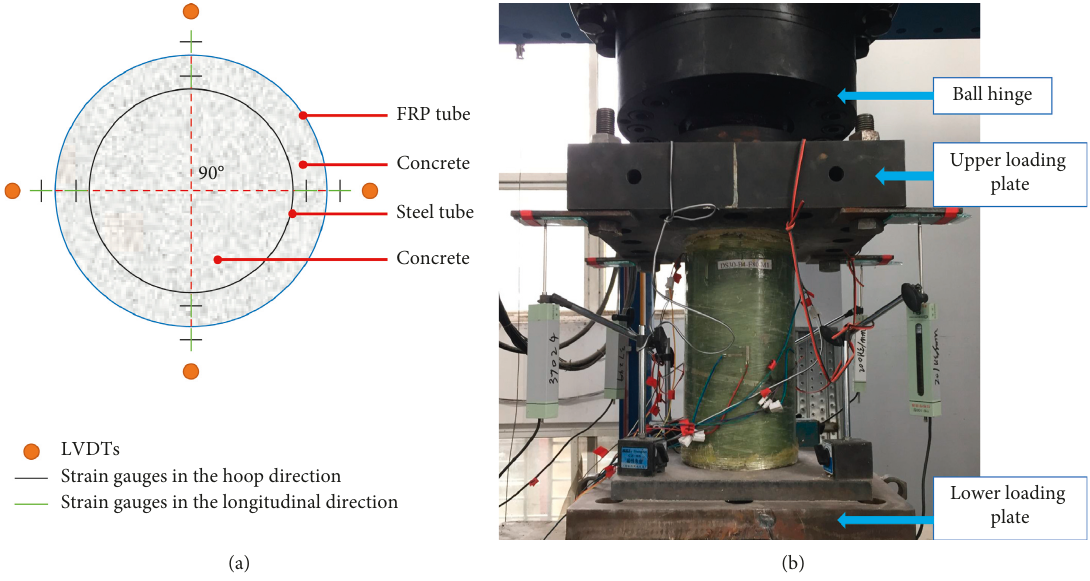
Figure 10: Experimental setup and instrumentation. (a) Planar layout of strain gauges and LVDTs. (b) Experimental